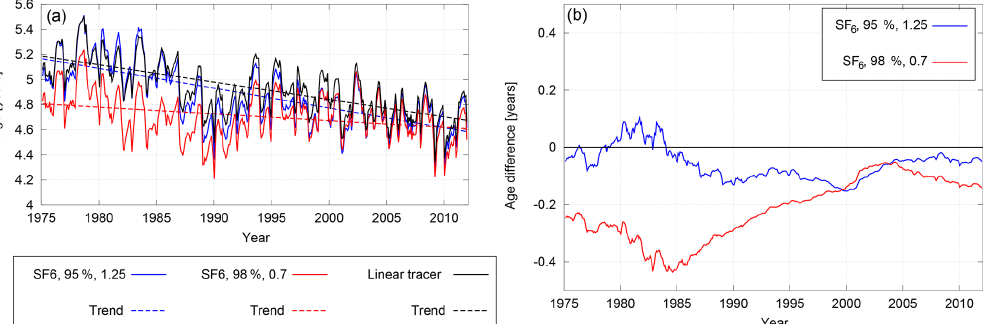
Figure 11. (a) Mean AoA and its trend derived from SF 6 for two sets of parameters (red and blue) and from the linear tracer (black) at 20hPa and 40 ◦ N from 1975 to 2011 from the RC1-base-07 simulation. (b) Accordingly mean AoA from the SF 6 tracer minus mean AoA from the linear tracer.